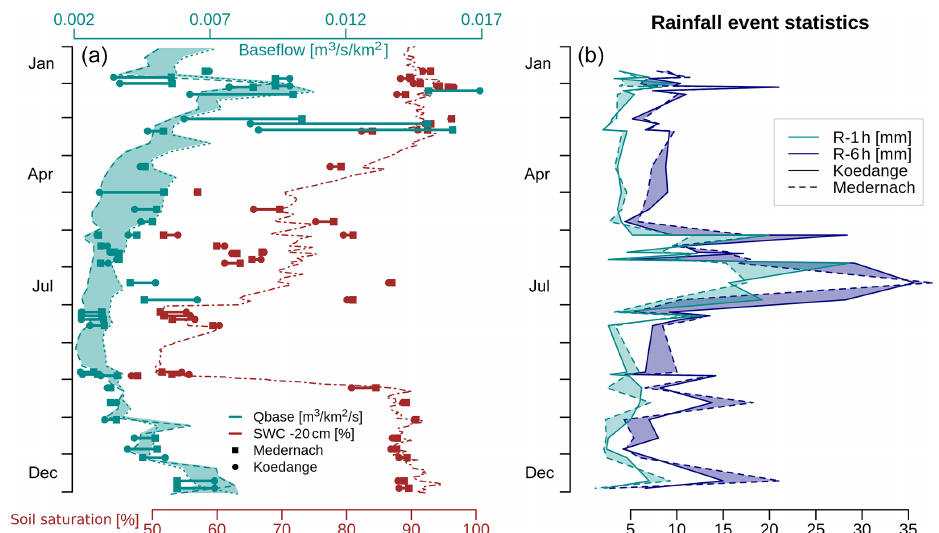
Figure 10. (a) The catchment state at the start of each event (points): the minimum discharge during the 7d before the event (Qbase, [m 3 km − 2 s − 1 ]), and the soil saturation at 20cm in depth (SWC20 [%]). The light blue color corresponds to the weekly average discharge minimum at Koedange (solid line) and Medernach (dashed line) over the studied period. The red line corresponds to the soil saturation calendar day average at 20cm depth in the Medernach Catchment over the same period. (b) The rainfall properties: the maximal hourly rainfall intensity (R-1h (mm), light blue), and the maximum rainfall amount over 6h (R-6h (mm), dark blue).